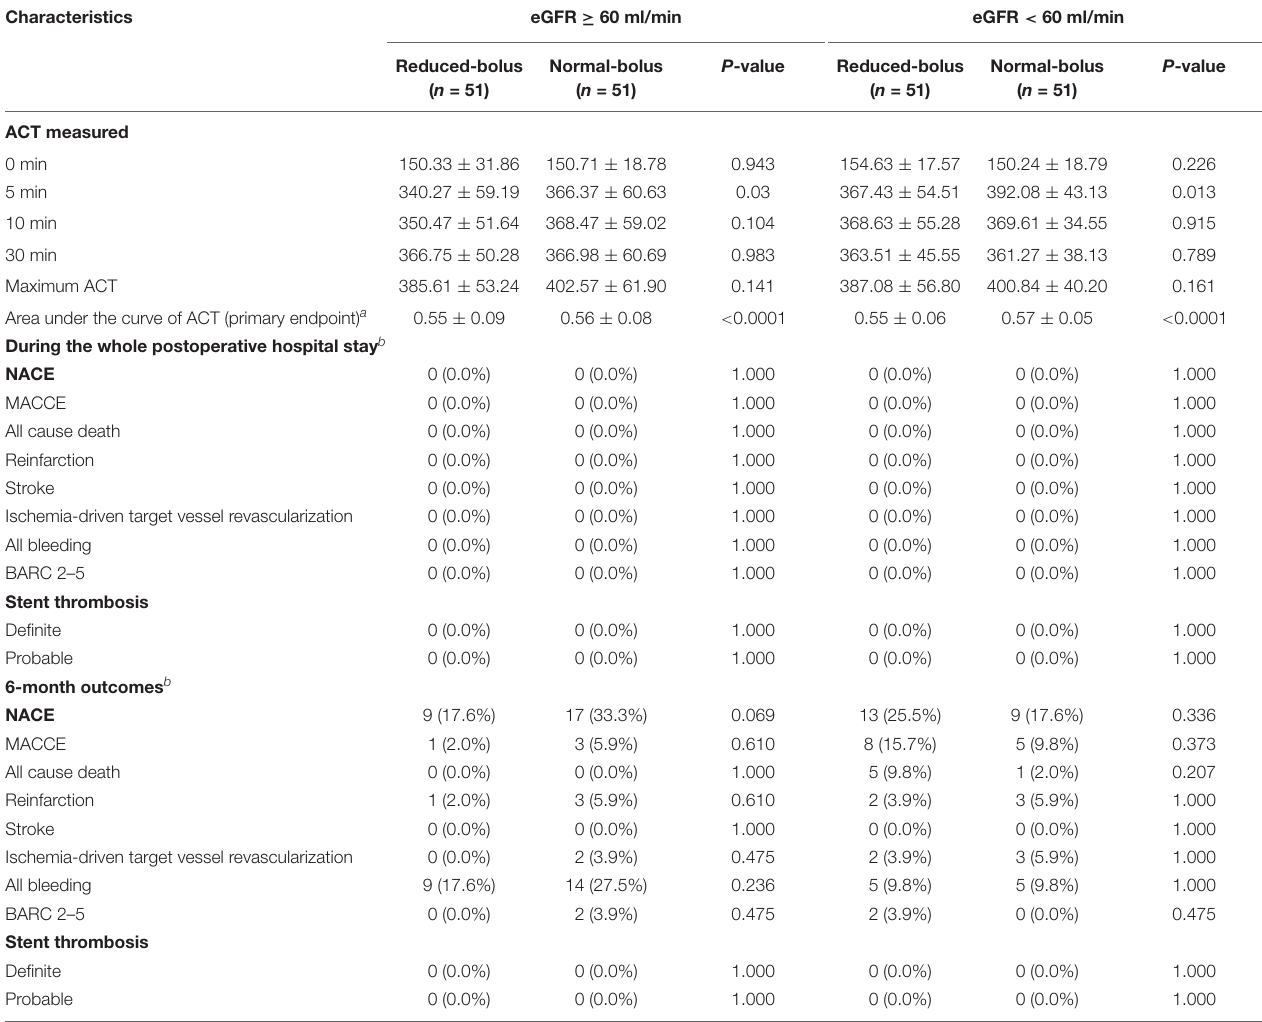
TABLE 5 | Clinical outcomes according to randomized treatment.